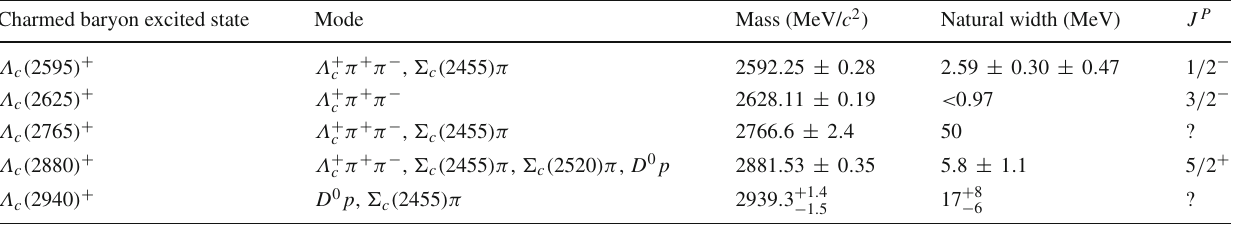
Table 297 Summary of excited Λ + c baryons